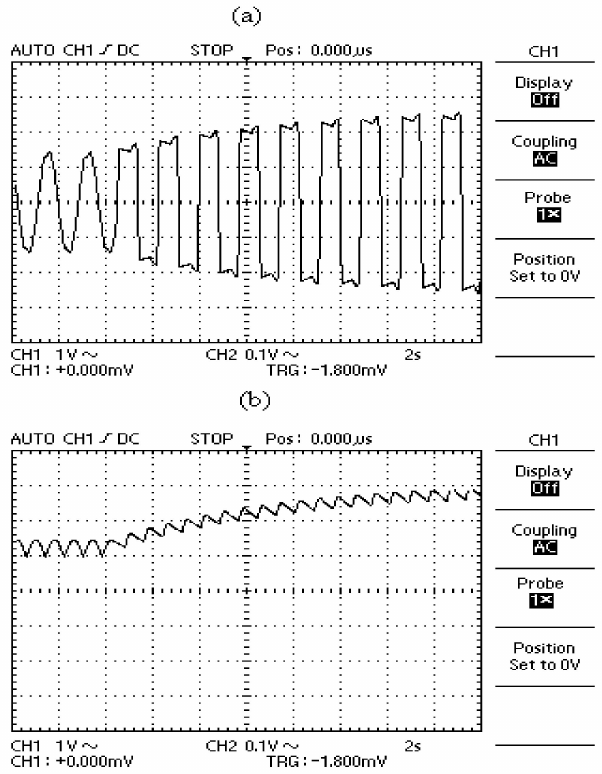
Figure 10. CDBFCL ( a ) NSDR current and ( b ) fault current.